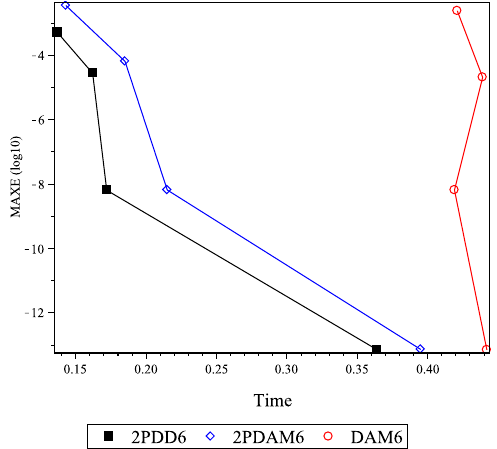
Figure 7. Performance graphs of time vs. log MAXE for Problem